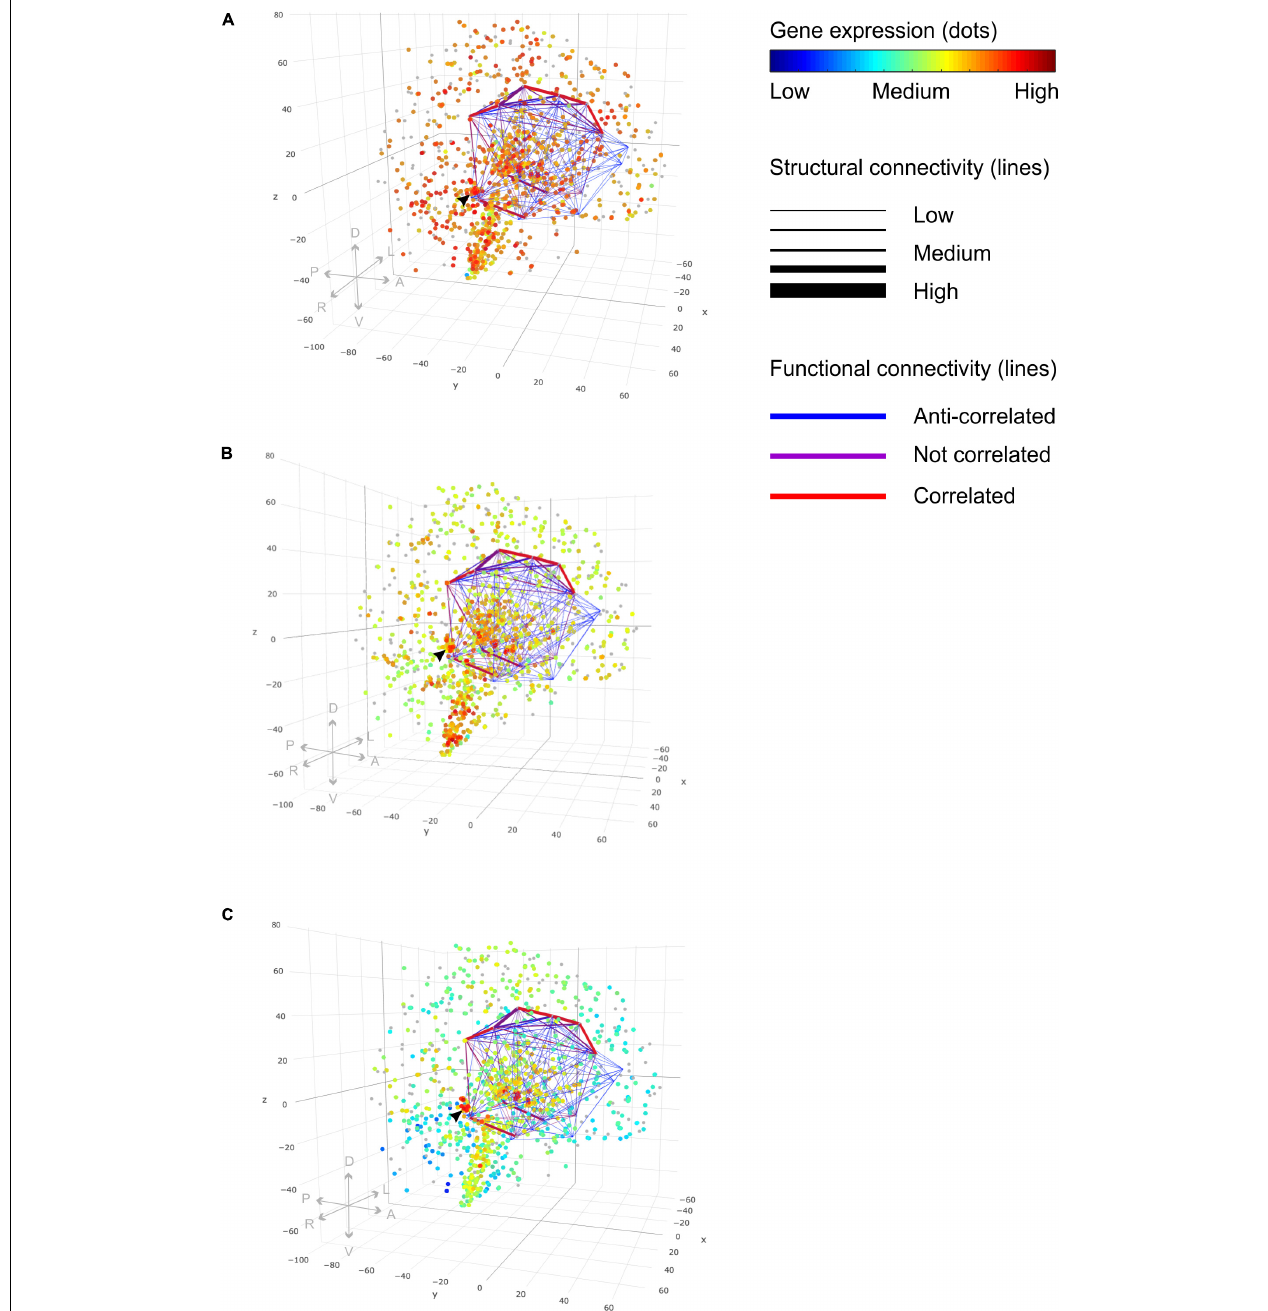
FIGURE 8 | Functional brain networks and gene expression. 3D lattice graphs in all three panels show connectome information on structural (line strength) and functional connectivity (line color) of the limbic lobe. Red lines indicate strong functional connectivity and blue lines weak functional connectivity. Strong functional connectivity means that activity of connected brain areas is correlated in time. Weak functional connectivity means that brain areas’ activities are anti-correlated. The black arrow head indicates the location of the hippocampal formation — a connection hub of the limbic lobe sub-network. Data were taken from rs-fMRI and DTI connectivity matrices from the NKI Rockland study (Nooner et al., 2012) through the USC Multimodal Connectivity database (Brown and van Horn, 2016). Legend on directions in the plot: anterior, “A”; posterior, “P”; left, “L”; right, “R”; dorsal, “D”; ventral, “V.” (A) Gene expression values for the gene “gmeb1” encode for the “glucocorticoid modulatory element-binding protein 1.” We see ubiquitously high gene expression with a particular accumulation of high values in the vicinity of the hippocampal connection hub region indicated by the black arrow. (B) Gene Expression for the gene “gmeb2” encoding for the “glucocorticoid modulatory element-binding protein 2” shows accumulation of high gene expression in the hippocampal formation, too. (C) Gene expression of gene “fkbp5” involved in receptor binding regulation of the glucocorticoid receptor shows highly localized increased values in the hippocampal formation, too. (See the main text for explanation.) Different gene expression values of multiple probes binding at the same location were plotted with 50% transparency to display the results of all probes. Gene expression values were taken from the Allen Human Brain Atlas (Hawrylycz et al., 2012).